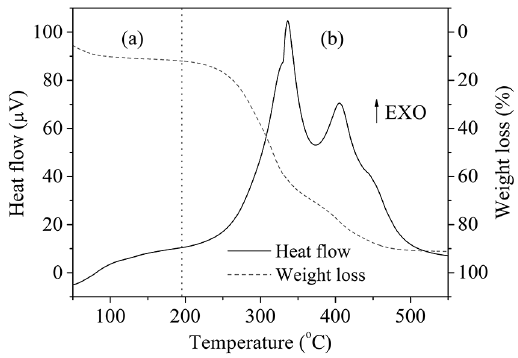
Figure 3: DSC/TGA curves of banana leaf samples.